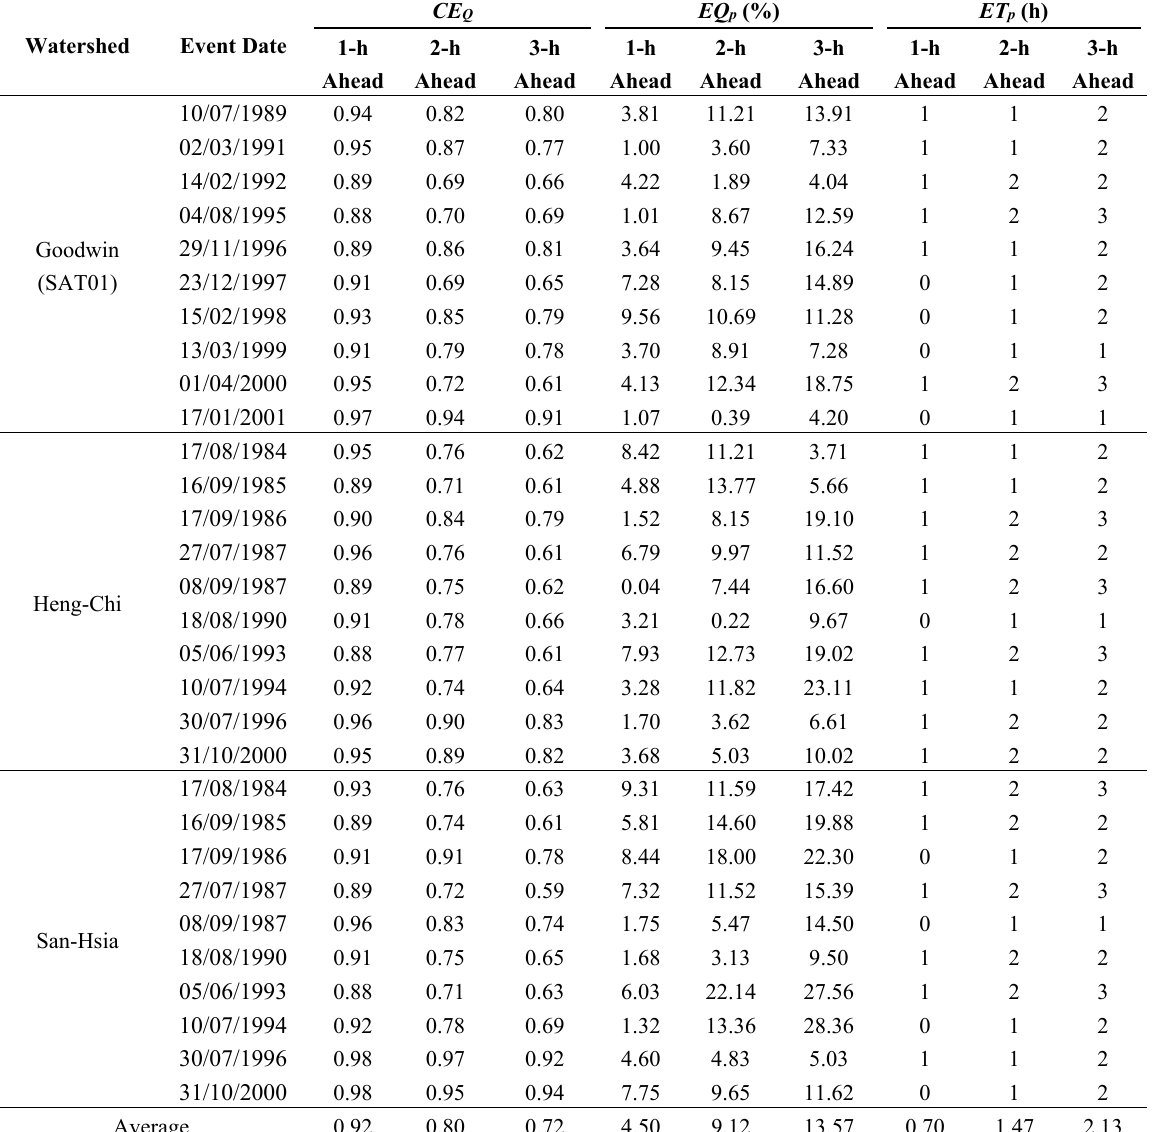
Table 7. Results of flow forecasting using forecast rainfall and flow updating technique. Watershed Event Date